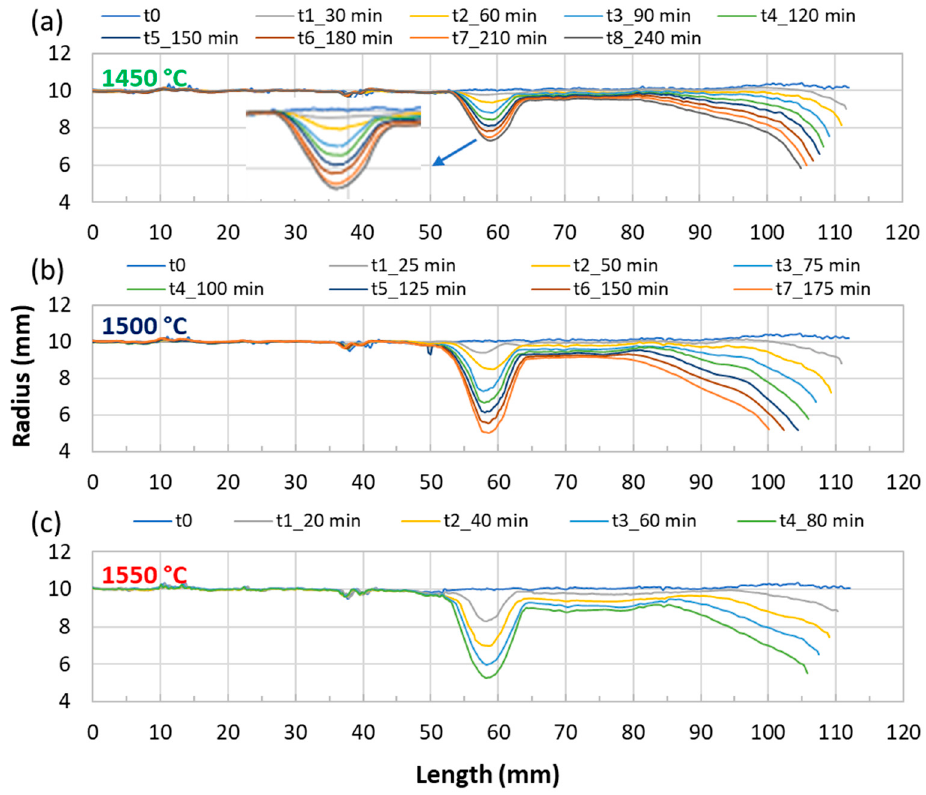
Figure 2. MCPs for magnesia dissolution at 200 rpm at ( a ) 1450 °C, ( b ) 1500 °C, and ( c ) 1550 °C.